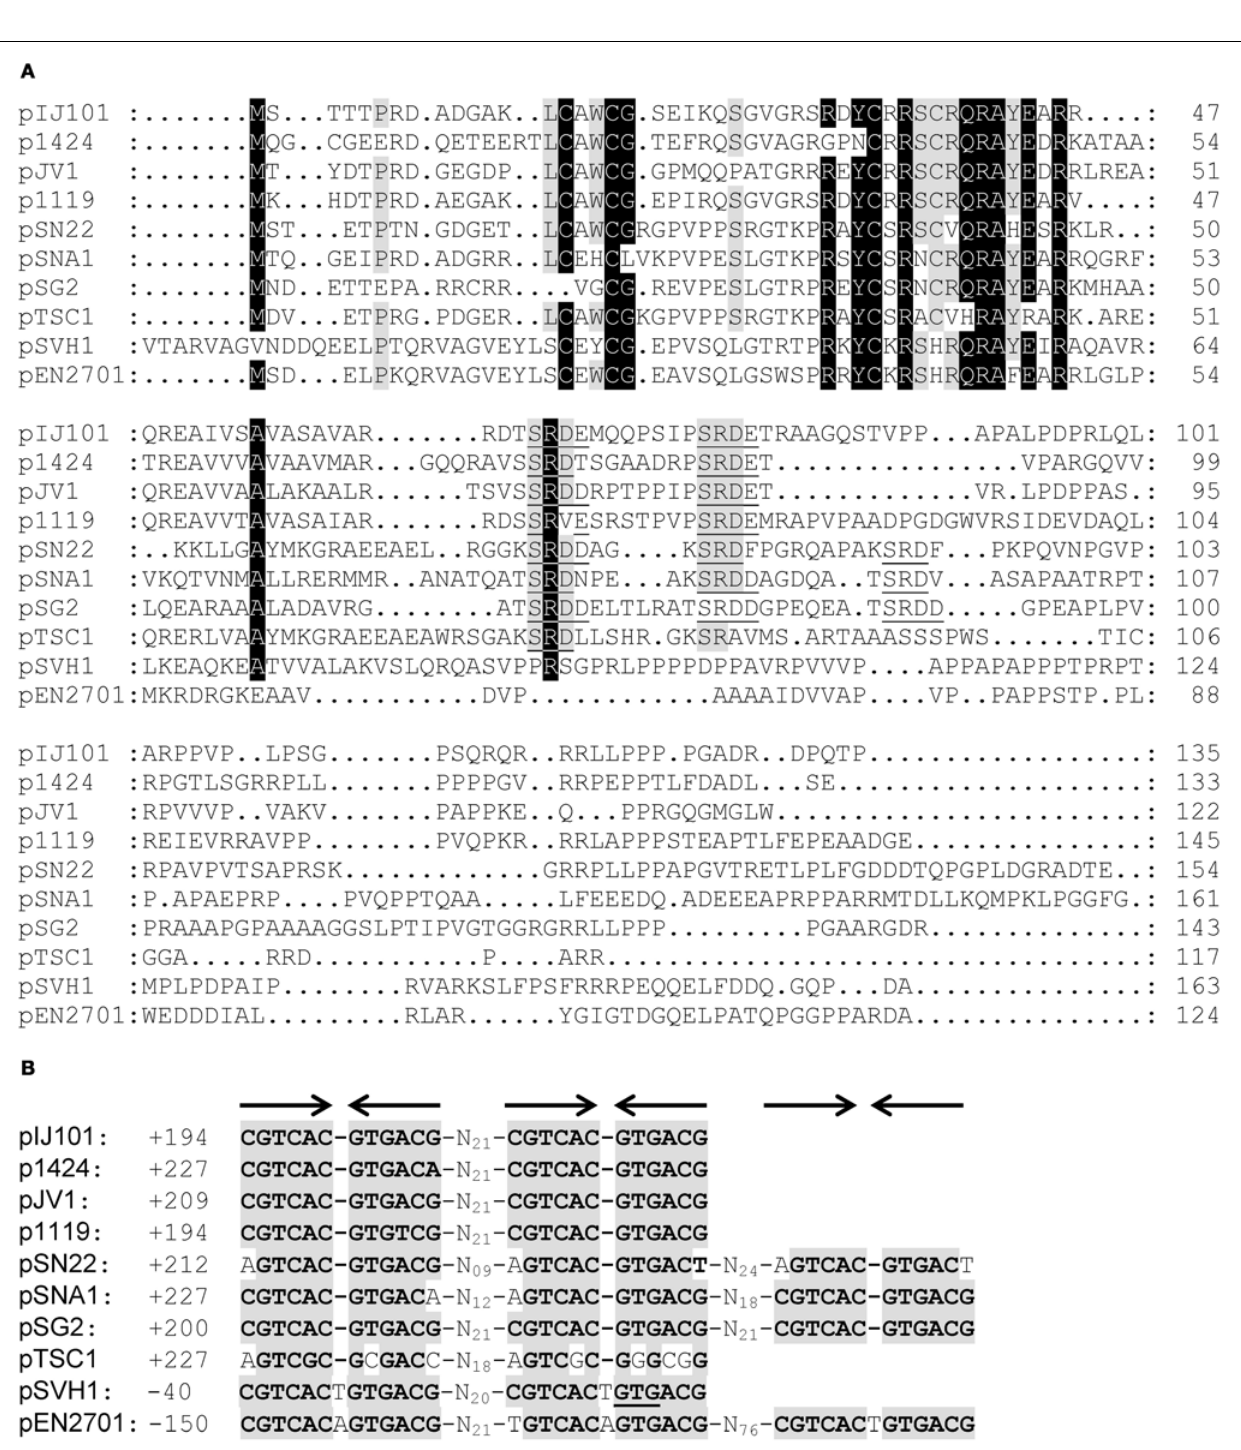
corresponding to sps is underlined. Multiple-sequence alignment of s pdA p alindromic (arrows) DNA s equence ( sps ) motifs associated with spdA genes (B) . Conserved residues are indicated by gray boxes. ± Indicates position from the first base of the start codon. On pSVH1, the second palindrome overlaps with the translational start codon (underlined) of spdA .